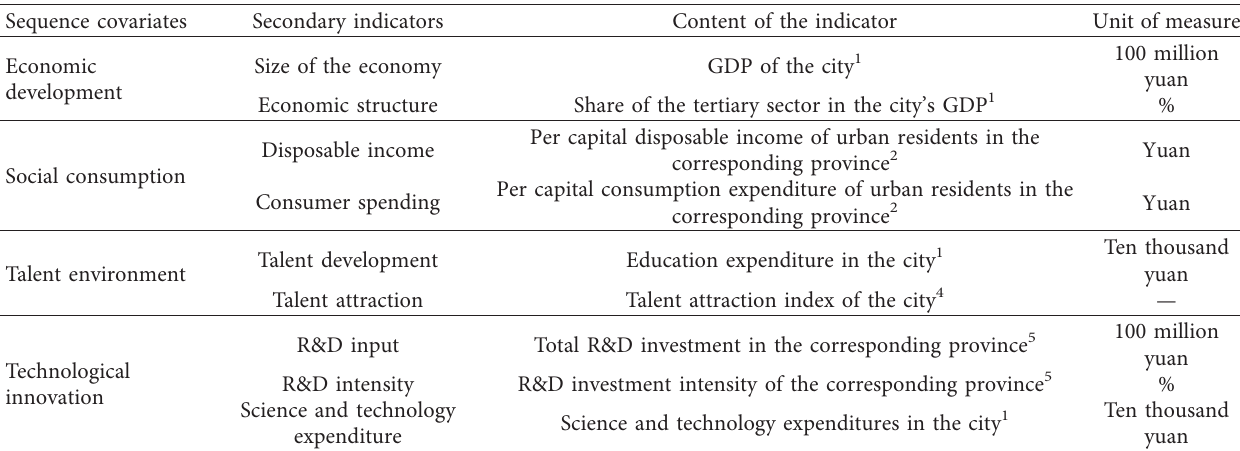
Table 2: Sequential covariate index system of the economic system.